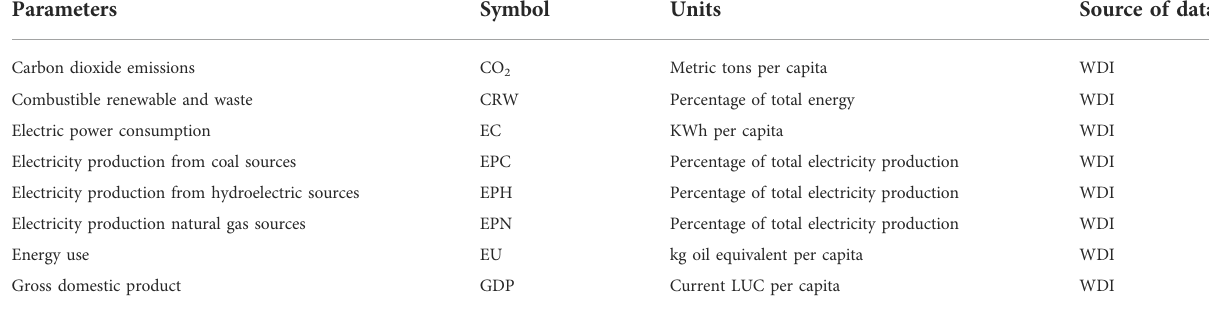
TABLE 1 Description of the study